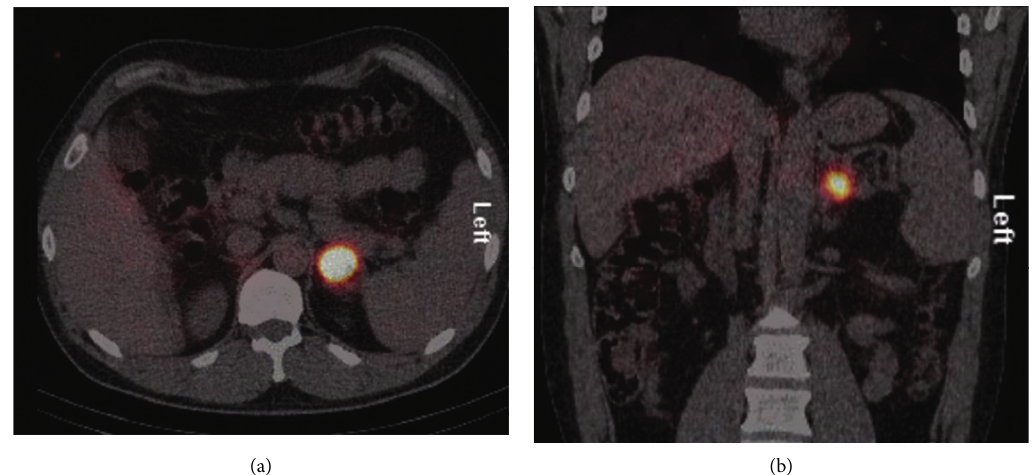
Figure 2: 123 I-metaiodobenzylguanidine (MIBG) scintigraphy scan showed abnormal focalintense radiotracer accumulation in the left adrenal